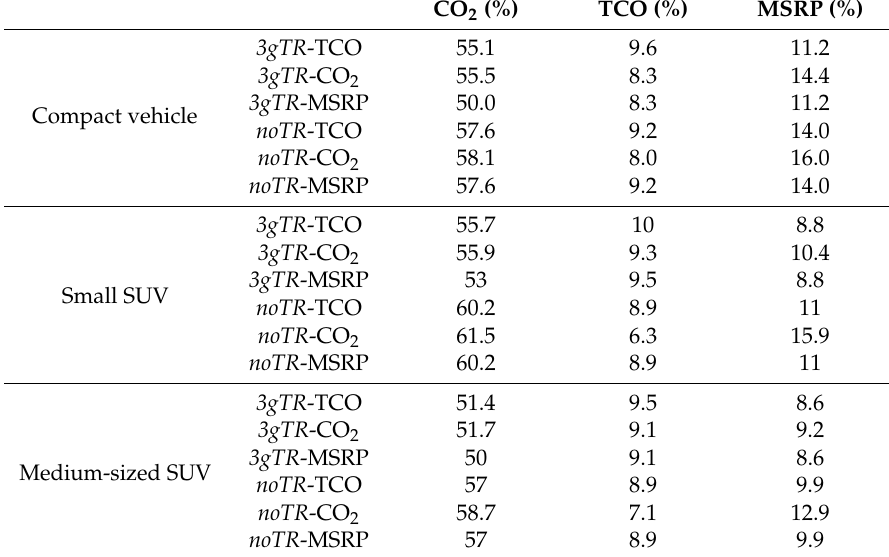
Table 9. Reduction in CO 2 emissions (first column), TCO (second column) and increment in MSRP (third column) of the six designs of the three vehicle segments, with respect to the conventional vehicle. CO 2 (%) TCO (%) MSRP (%) 3gTR Compact vehicle